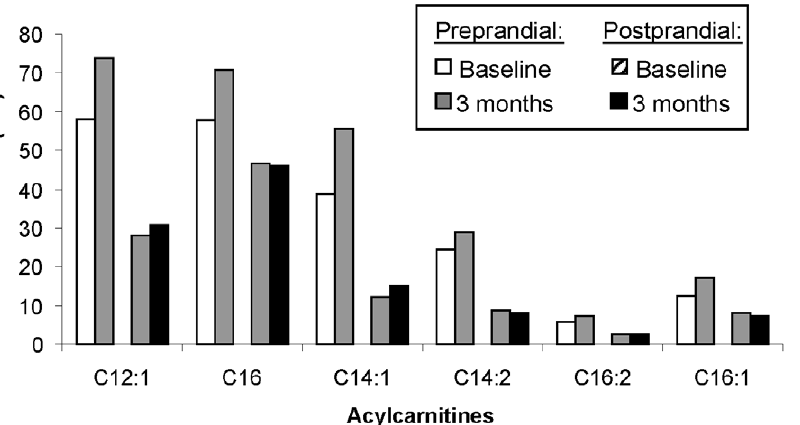
Figure 5. Preprandial and postprandial concentrations of acylcarnitines in response to caloric restriction (CR). Baseline and three month acylcarnitine concentrations are shown for both fasting (preprandial) and postprandial assessments. The six acylcarnitines that had the largest loadings on the acylcarnitine factor (see Table 1) are shown.